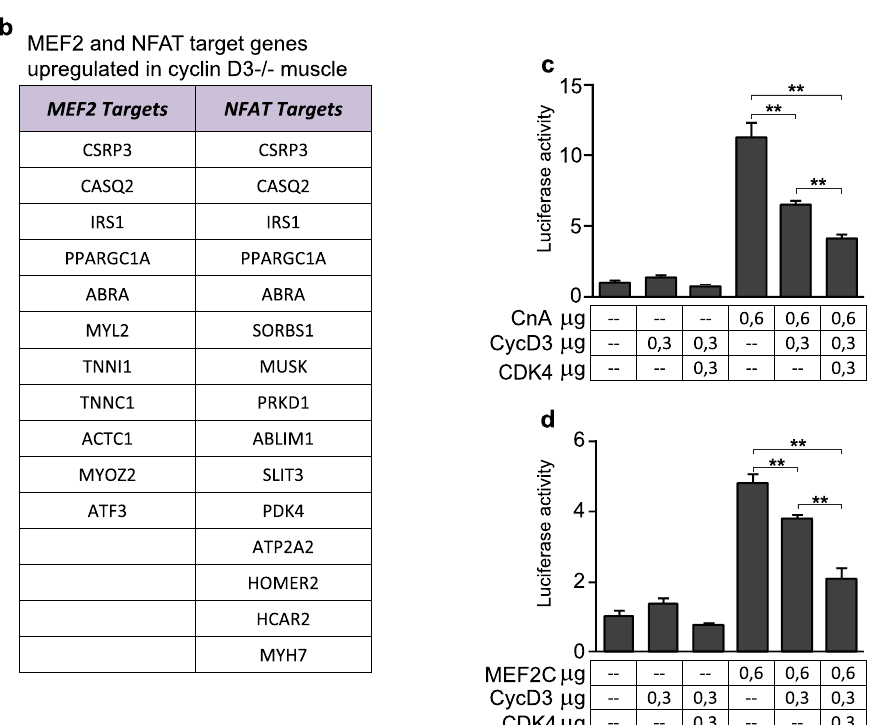
To address this issue, we performed transient transfection assays in cultured muscle cells using a lucif- erase reporter gene linked to a well-characterized promoter region from the myoglobin gene (Mb) that includes MEF2 and NFAT binding sites, both of which direct the selective expression of myoglobin in slow